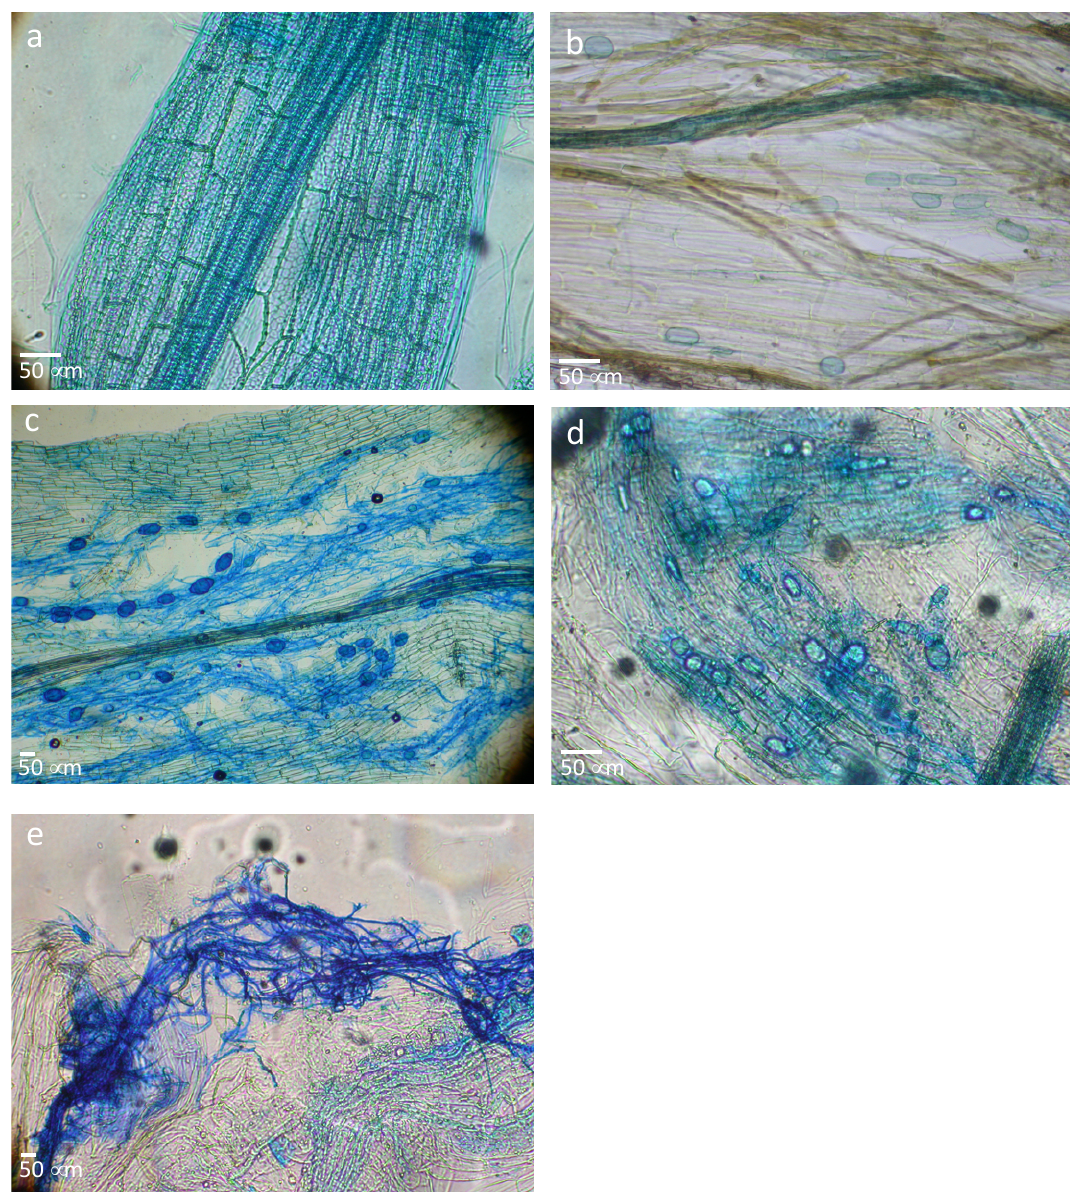
Figure 7. Microphotographs of roots stained for mycorrhizal association observation: root parts from N. caerulescens ( a ), A. arenaria ( b ), T. pratense ( c ), B. phoenicoides ( d ) and, T. vulgaris ( e ). AM mycelium and vesicles appear in dark blue. Scale bars are directly on the microphotographs.